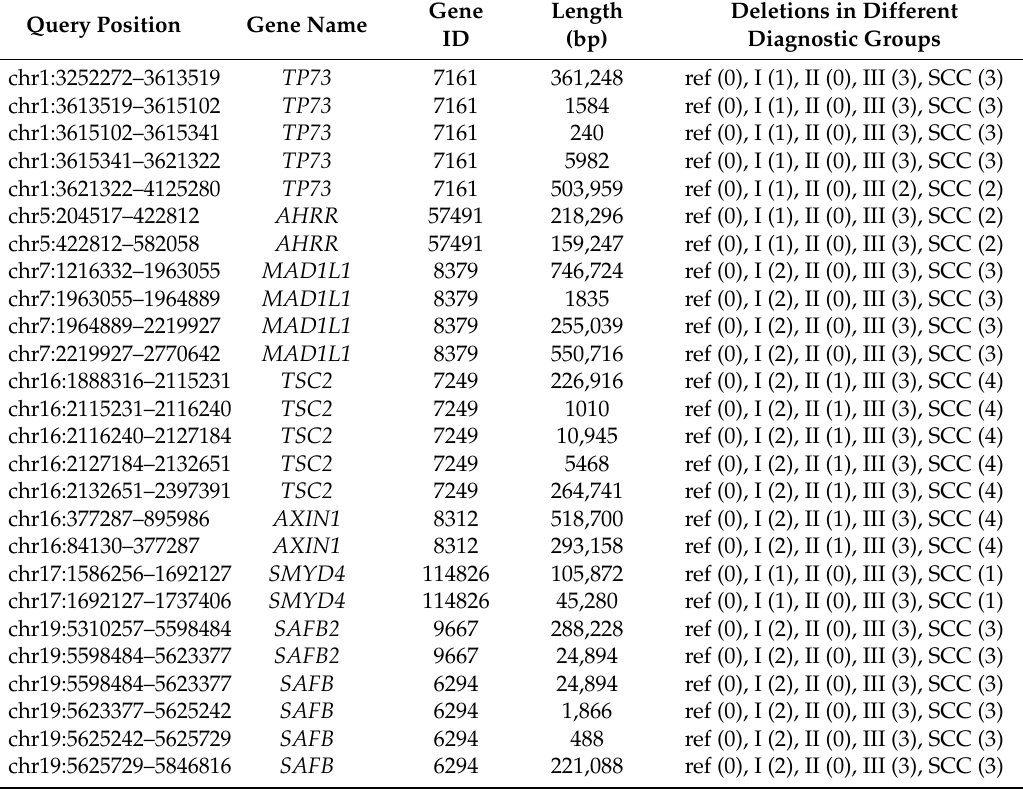
Table 5. Newly-identified CNAs (deletions) contain known tumor suppressor genes in cases only. Query